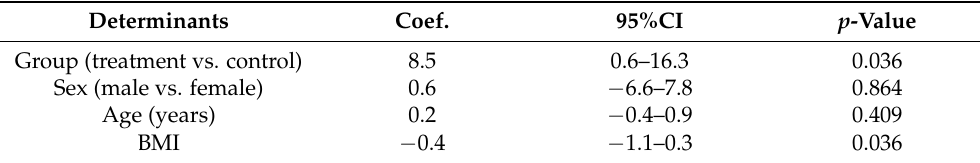
Table 6. Analysis of the determinants of the difference between MCS-12 T1 and MCS-12 T0 in a multivariate linear regression model. Determinants Coef. 95%CI p -Value Group (treatment vs. control)